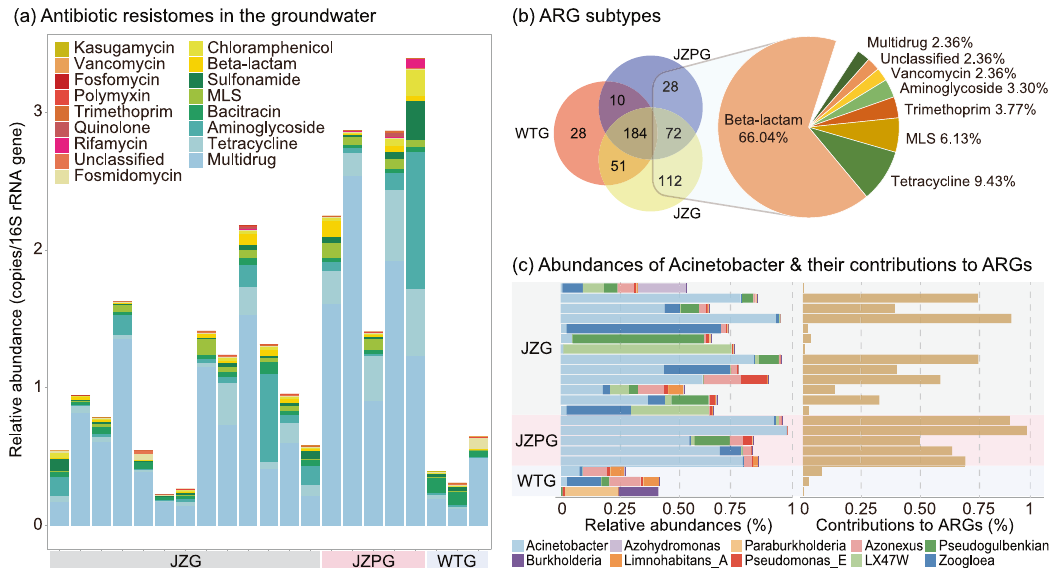
Fig. 1 Antibiotic resistome and bacterial community composition in the groundwater. a Relative abundance of ARG types in the groundwater. b Unique and shared ARG subtypes in the groups. Values in the venn plot represent ARG numbers, and the percentages in pie plot are proportion of the ARGs only detected in JZG and JZPG. c Relative abundance of top ten genera with the Acinetobacter contribution to the resistome. ARG antibiotic resistance gene, MLS macrolide-lincosamide-streptogramin, JZG residential groundwater in the swine